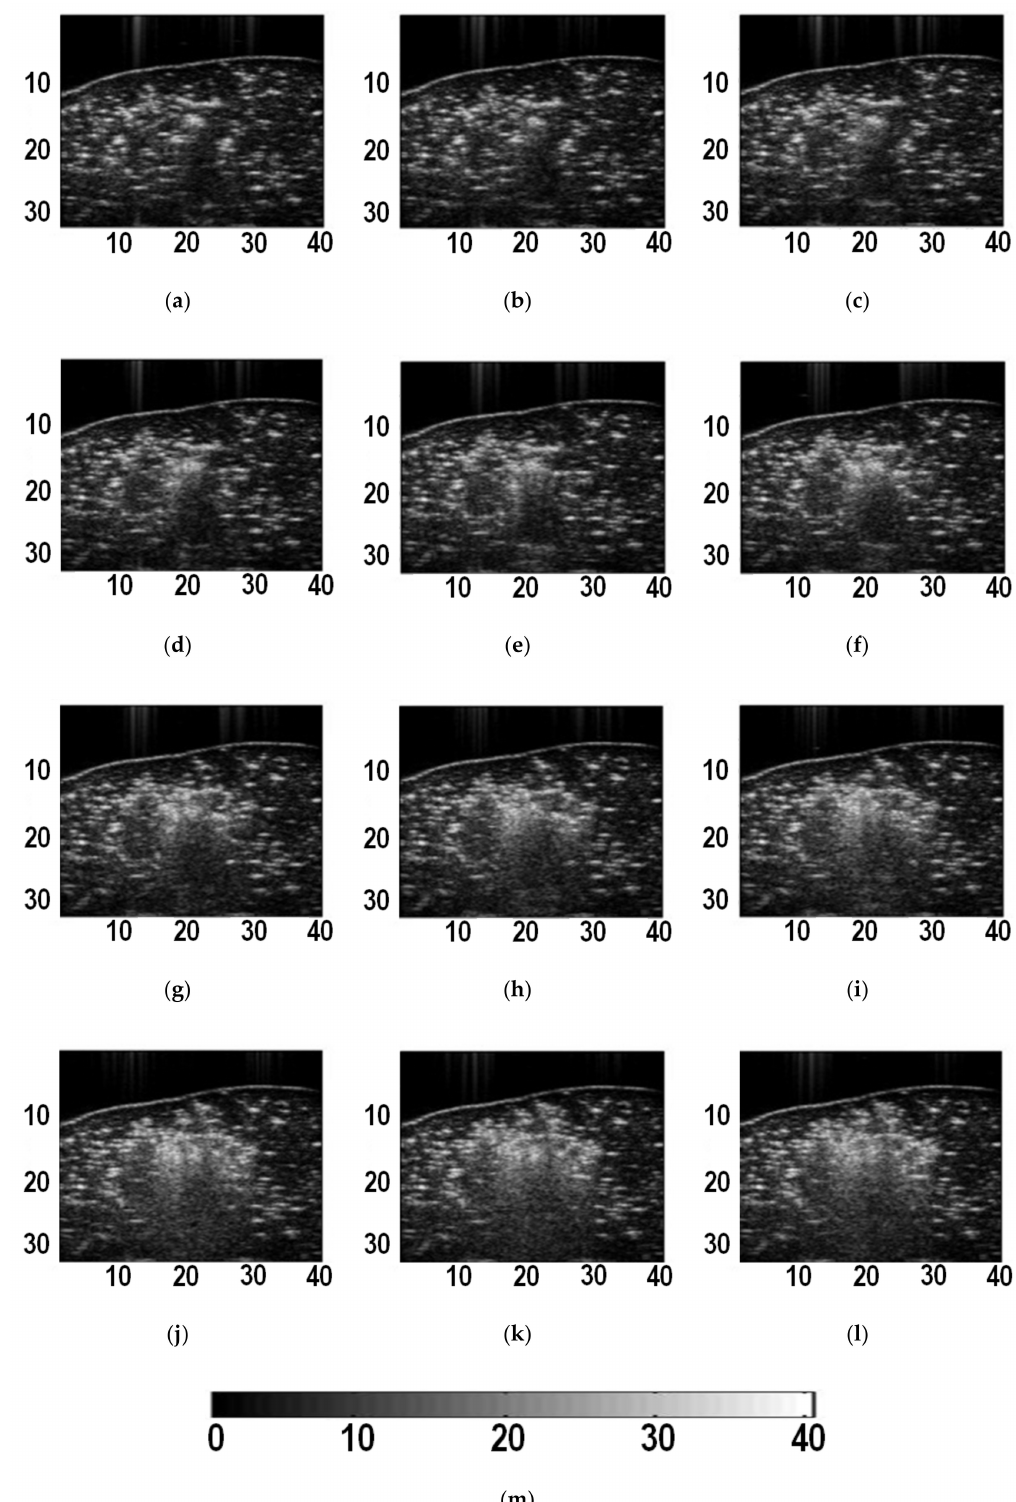
Figure 2. B-mode ultrasound images of liver tissue at different time during ablation. ( a ) 5 s; ( b ) 10 s; ( c ) 15 s; ( d ) 20 s; ( e ) 25 s; ( f ) 30 s; ( g ) 35 s; ( h ) 40 s; ( i ) 45 s; ( j ) 50 s; ( k ) 55 s; ( l ) 60 s. ( m ) is the color bar for ( a )-( l ). The units of ( a )-( l ) are mm. The unit of ( m ) is